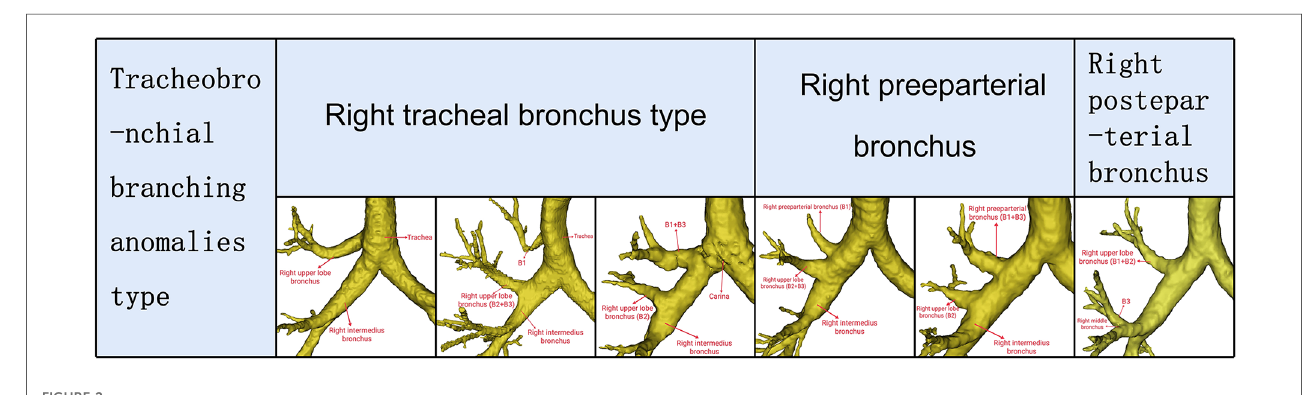
FIGURE 2 Tracheobronchial branching abnomalies type of RUL